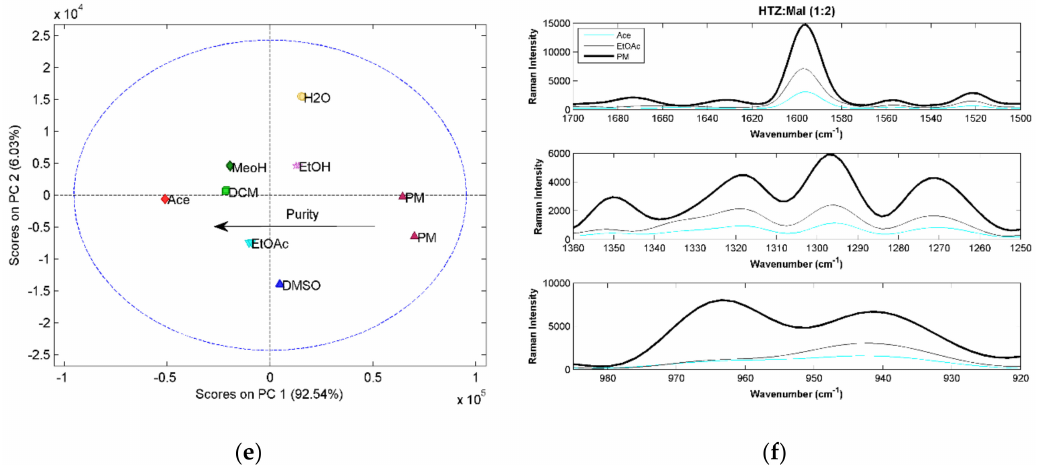
Figure 3. ( a ) PCA score plot constructed with the MIRS spectra from the system HTZ:Mal (1:2); ( b ) MIRS spectra of the samples produced with DCM and EtOAc and from the PM; ( c ) PCA score plot constructed with the NIRS spectra from the HTZ:Mal (1:2); ( d ) NIRS spectra of the samples produced with Ace and EtOAc and from the PM; ( e ) PCA score plot constructed with the RS spectra from the HTZ:Mal (1:2); ( f ) RS spectra of the samples produced with Ace and EtOAc and from the PM. Colors refer to different solvents (dark green: MeOH; pink: EtOH; red: Ace; green: DCM; dark blue: DMSO; blue: EtOAc; yellow: H 2 O; dark red: